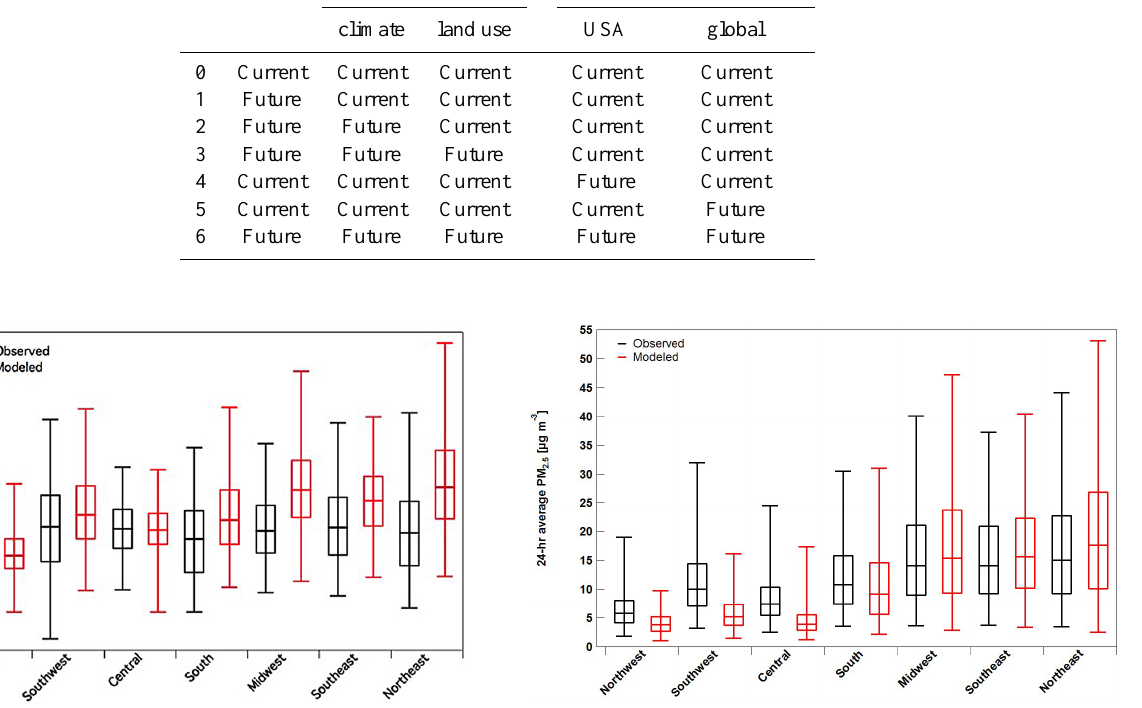
Figure 7. Shown are the 2nd, 25th, 50th, 75th, 98th percentiles of observed vs. modeled values of 24h average PM 2 . 5 for each